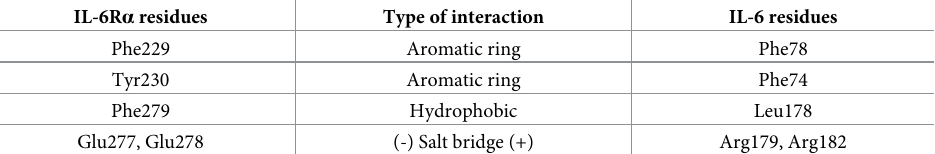
(HBD) � 5 [23]. The ADMET Predictor 10.0 software [24] was used to evaluate the compounds’ absorption, distribution, metabolism, elimination, and toxicity properties compared to reference Table 1. Interaction between hot-spot residues of IL-6 and the corresponding residues of its receptor at the bind- ing site